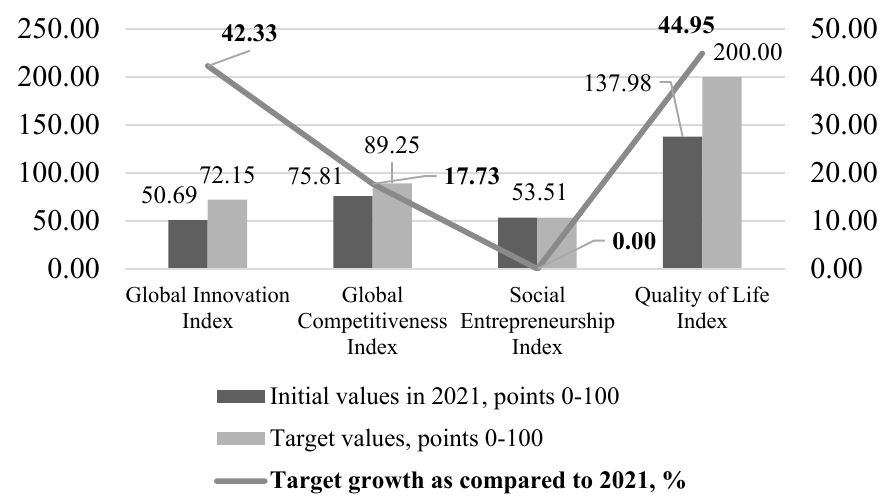
Figure 1. Perspectives of improving the practice of managing the risks of innovative activities focused on the consumer market in countries with high income and upper middle income. Source: Calculated and compiled by the authors.